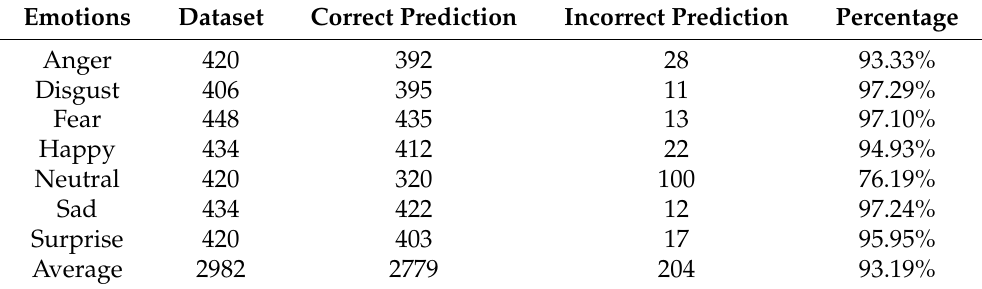
Table 23. Cross dataset testing result of Model 1 after 100 epochs.